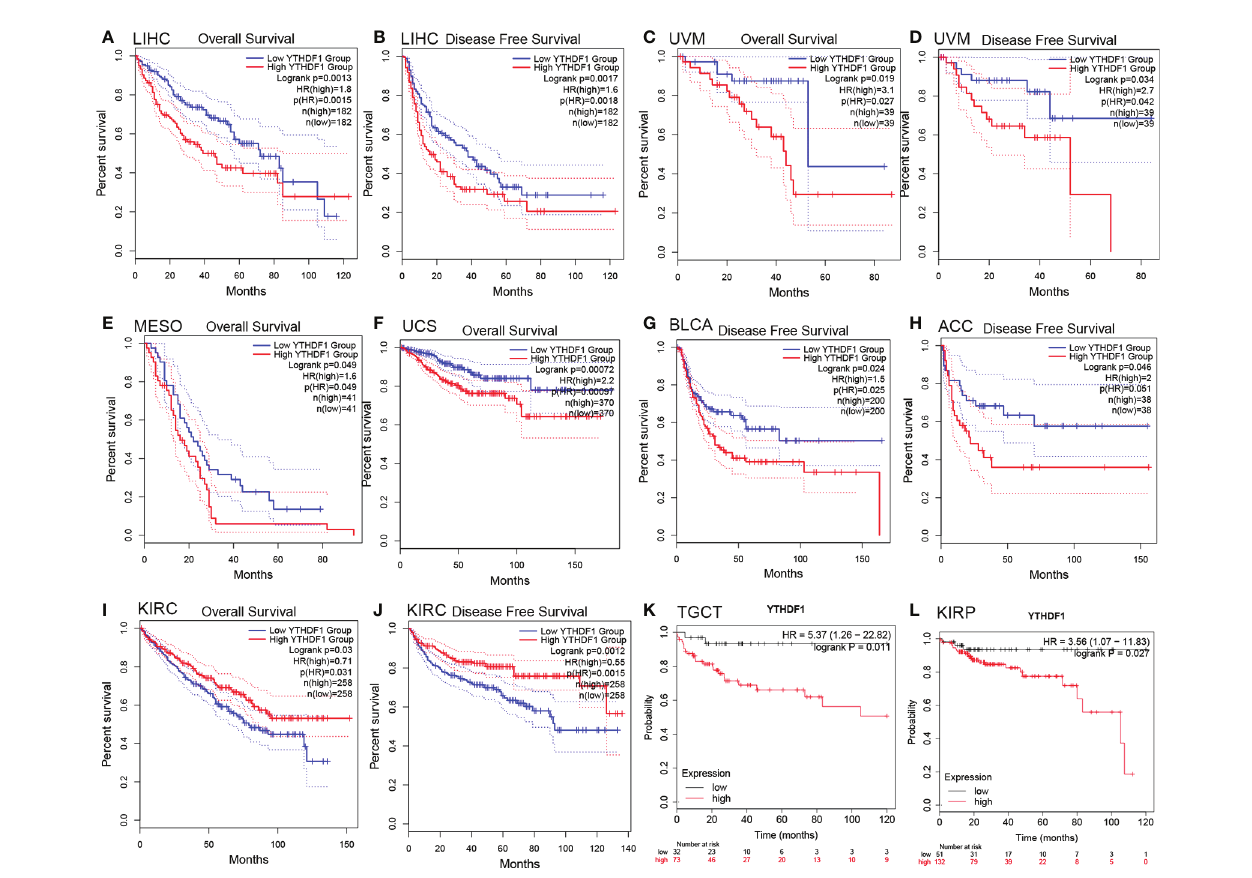
FIGURE 2 | Kaplan-Meier survival curve of human cancers with high and low YTHDF1 expression analyzed by the GEPAI database (A – J) and the Kaplan-Meier plotter database (K, L) . (A – D) High YTHDF1 expression was related to worse OS and DFS in LIHC (n = 364) and UVM cohorts (n = 78). (E, F) High YTHDF1 expression was related to worse OS in MESO (n = 82) and UCS cohorts (n = 740). (G, H) High YTHDF1 expression was related to worse DFS in BLCA (n = 400) and ACC cohorts (n = 76). (I, J) High YTHDF1 expression was related to better OS and DFS in KIRC cohorts (n = 316). (K, L) higher YTHDF1 expression was related to poorer RFS in TGCT (n = 105) and KIRP (n = 183). OS, overall survival; DFS, disease free survival; RFS, relapse-free